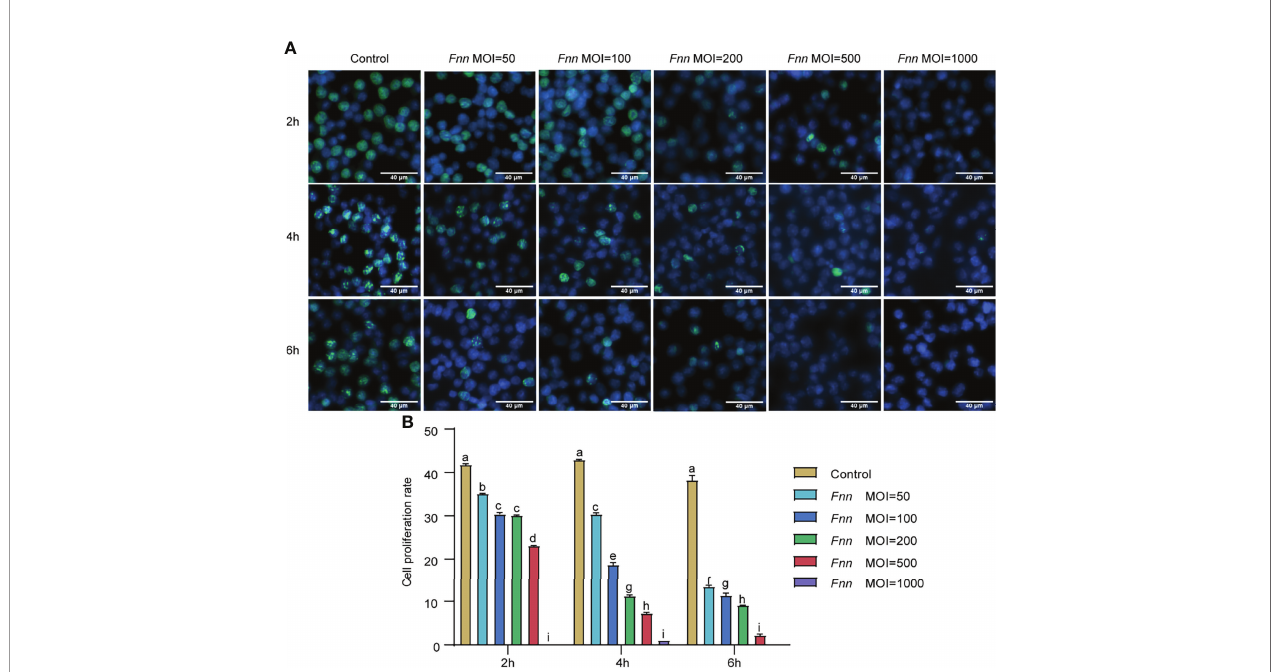
FIGURE 1 | Effects of F. necrophorum on macrophages proliferation. (A) EdU assay of macrophages after F. necrophorum stimulation (MOIs of 0, 50, 100, 200, 500, and 1000) at 2, 4, and 6 h. Scale bar: 40 m m. (B) Cell proliferation rate of macrophages detected by EdU assay (n = 3), (No signi fi cance with the same letter, signi fi cant difference with different letters, P <